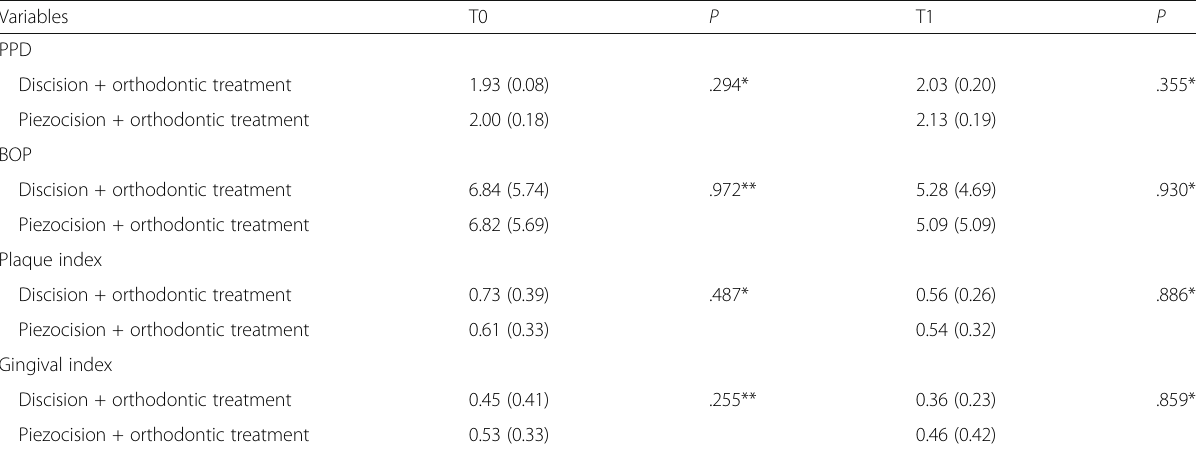
Table 3 Comparison of mandibular periodontal parameters in experimental groups according to different treatment periods Variables T0